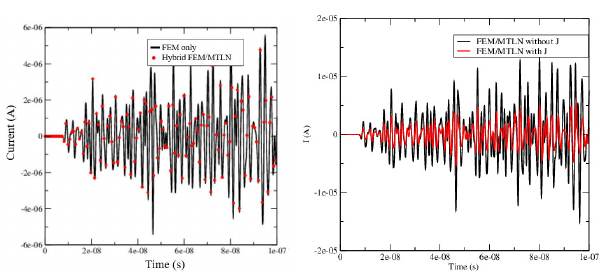
FIGURE 9: Current on wire 1 of tube T1. FEM/MTLN results with and without J current density sources in the Maxwell-equations. "FEM only": full-wave FEM method enbedding the thin-wire model of the wiring. "Hybrid FEM/MTLN": our hybrid method.